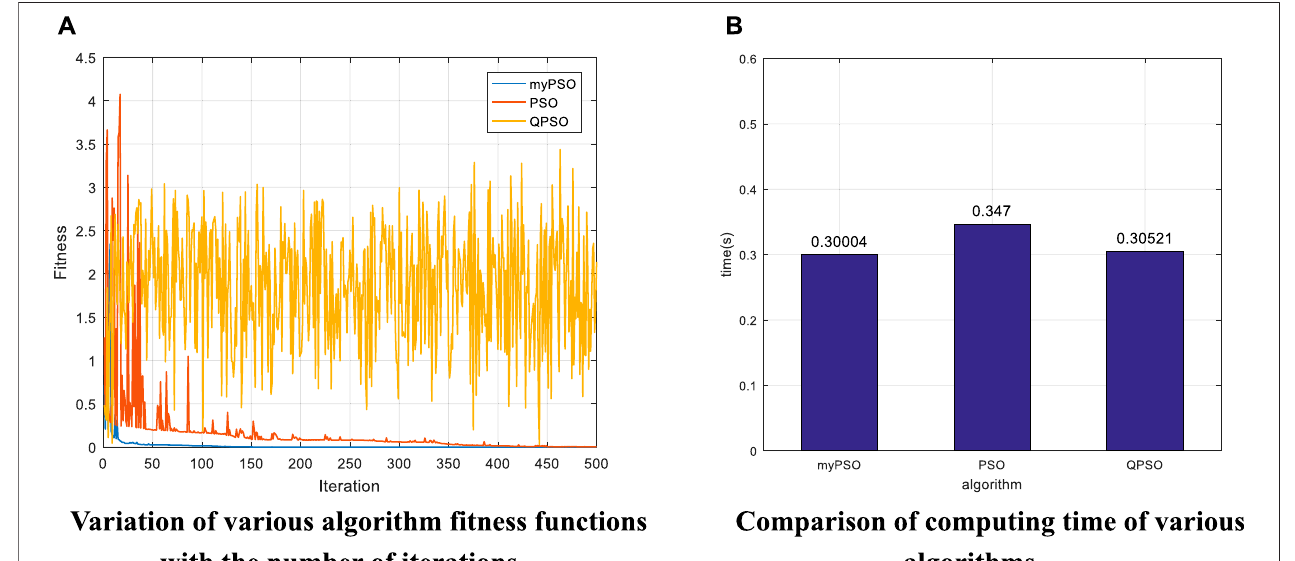
FIGURE 8 | Comparison of the results of various algorithms for seven-degree-of-freedom robotic arms.